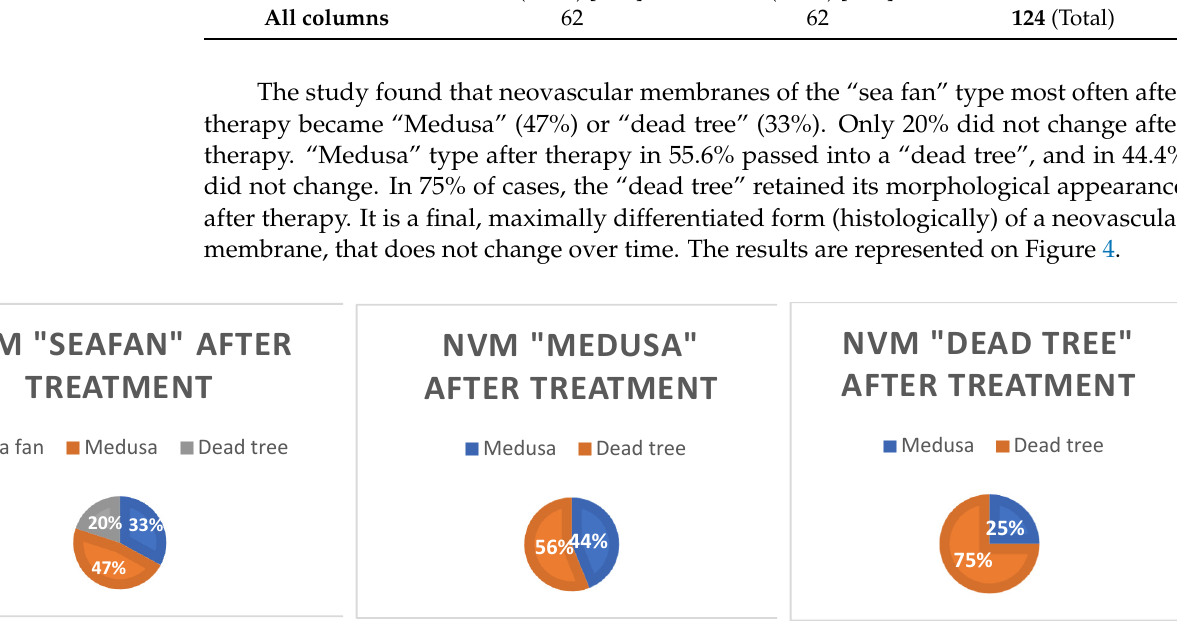
Figure 4. Remodeling NV type “sea fan”, “Medusa”, “dead tree” after therapy.